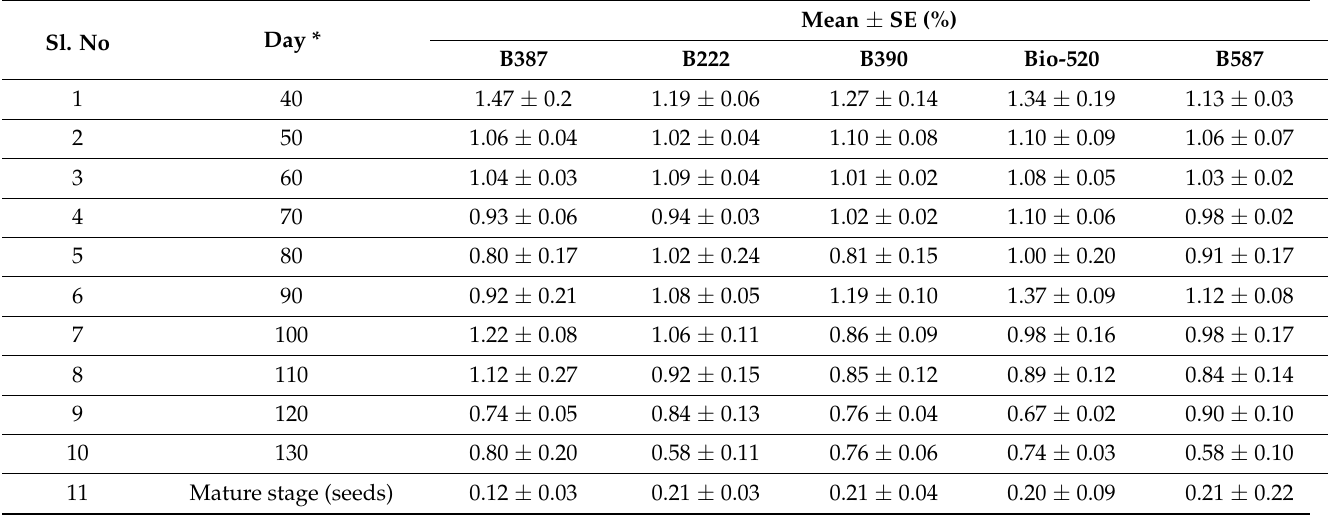
Table 4. Total ODAP content (%) in different plant development stage in L. sativus during the year